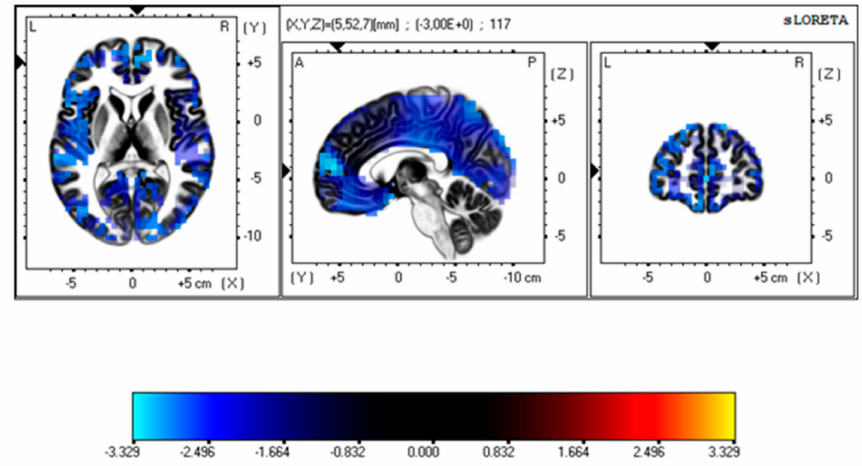
Figure 7. The sLORETA voxels expressing statistical analysis results of the comparison of changes of laser evoked potential (LEP) sources in the basal condition and during fast finger tapping between the controls and the fibromyalgia (FM) patients. The maps express the maximal di ff erence in light blue, corresponding to frontal and limbic regions. For details of the analysis, see Table